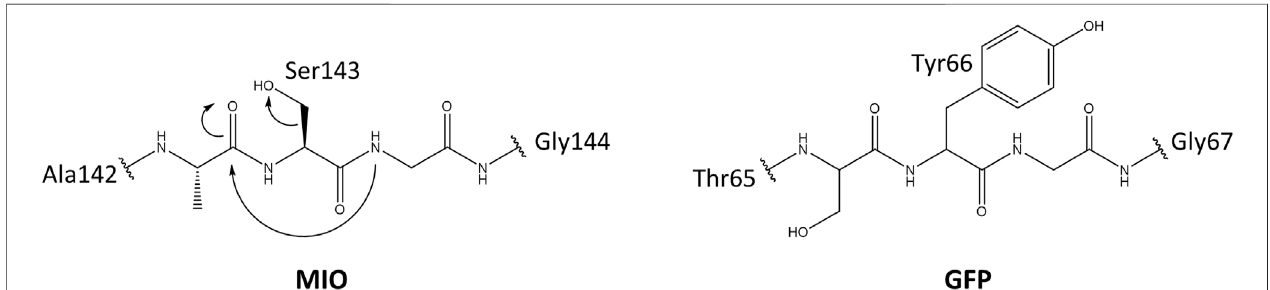
FIGURE 1 | The proposed mechanism for the MIO in HAL and GFP formation by posttranslational modi fi cation.